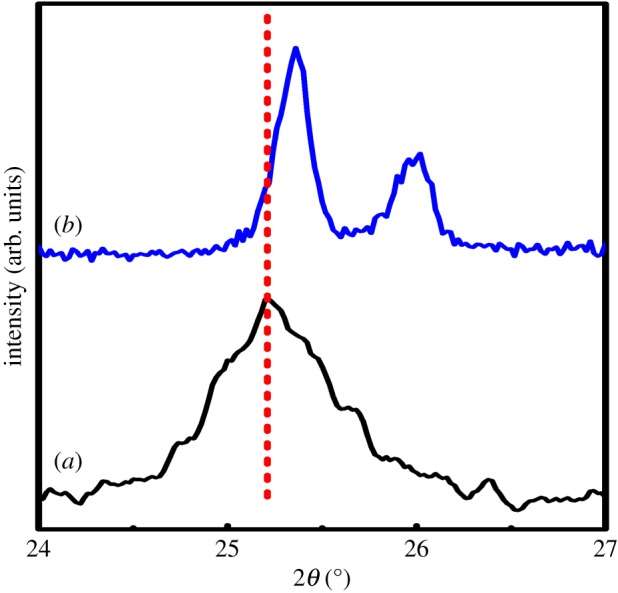
Magnifying XRD patterns of (a) TiO2, (b) TiO2: Sr in the region between 24° and 27°.